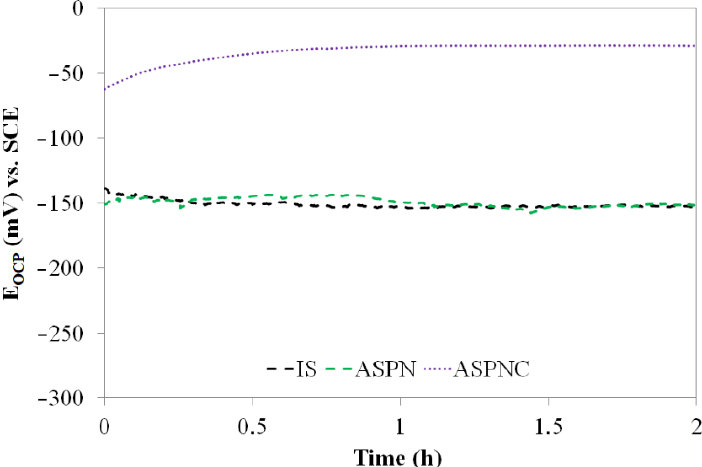
Figure 4. OCP (open circuit potential) curves of AISI 316L steel in its initial state (IS) and after ASPN and ASPNC; SCE—saturated calomel